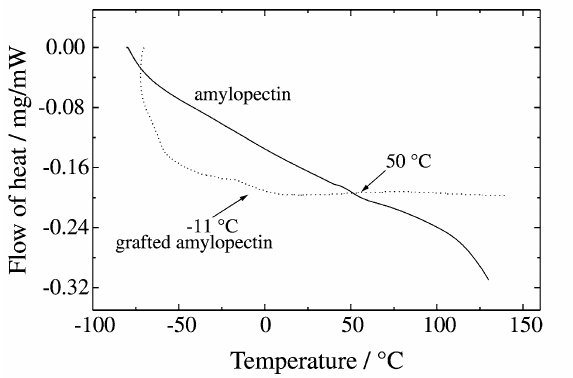
Figure 9. DSC curves of pure and amylopectin-rich stanch grafted with toluene poly(propylene oxide)